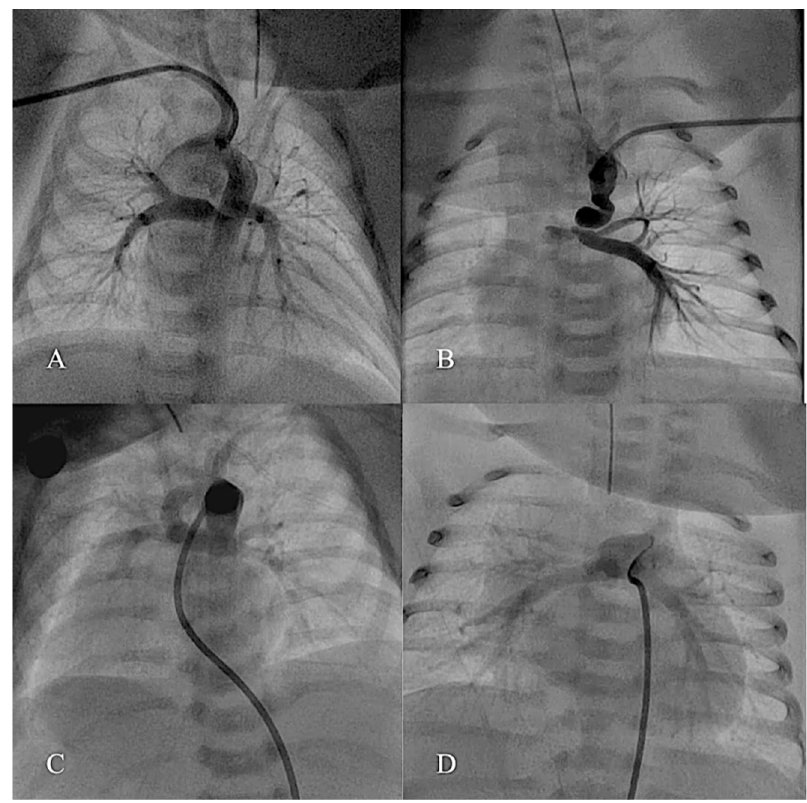
Figure 2. Different approaches for ductal stenting. ( A ) From right axillary artery. ( B ) From left axillary artery. ( C ) From femoral vein to ascending aorta. ( D ) From femoral artery.